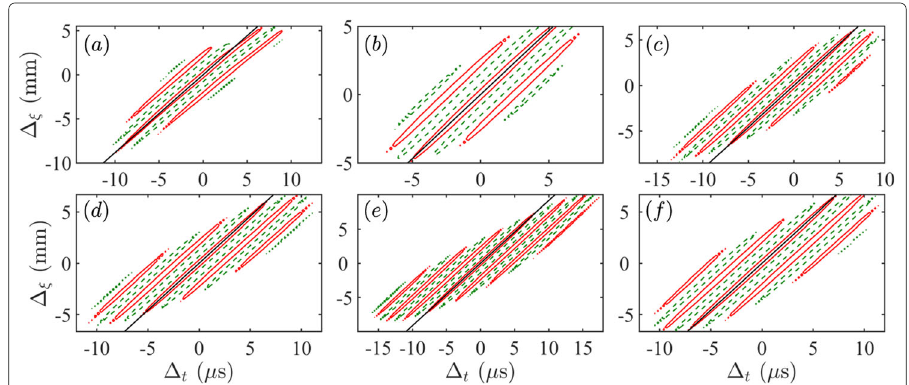
(cid:2) (cid:3) (cid:7) ξ ,0, (cid:7) Fig. 18 C pp for high-frequency wall pressure at probe points in Group 2. Solid and dashed t contours for 0.5 and -0.5 respectively. Solid lines represent (cid:7) ξ /(cid:7) t = 0.85 q ∞